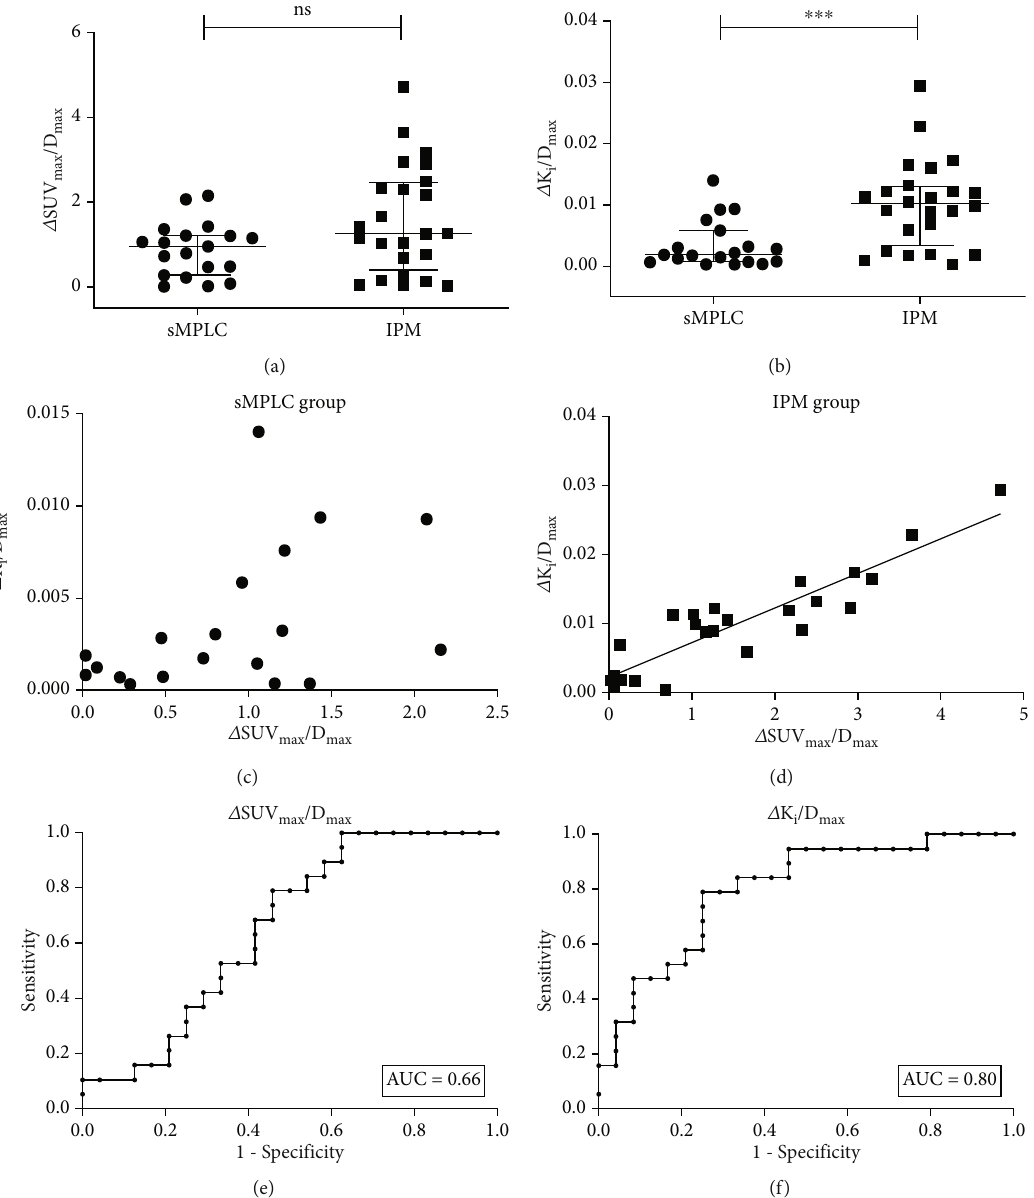
Figure 3: sMPLC vs. IPM: absolute di ff erences of SUV / D or K i / D and ROC curve analysis. (a, b) △ K i / D was more sensitive max max max max / D in identifying sMPLC. Data are shown as median with interquartile range. Mann – Whitney test, ∗∗∗ p < 0 : 001 , than △ SUV max max / D and △ K i / D in the sMPLC and IPM groups. (c) There was no ns=not signi fi cant. (c, d) Correlation between △ SUV max max max / D and △ K i / D in the sMPLC group. (d) There was a good correlation correlation (Pearson r = 0 : 45 , p > 0 : 05 ) between △ SUV max max max / D and △ K i / D in the IPM group. (e) ROC curve ( AUC = 0 : 66 , (Pearson r = 0 : 91 , 95% CI: 0.79-0.96, p < 0 : 0001 ) between △ SUV max max max / D . (f) ROC curve ( AUC = 0 : 80 , moderate diagnostic value) for △ K i / D . For the optimal cut-o ff value low diagnostic value) for △ SUV max max max = 0 : 0059 with a sensitivity of 79% and speci fi city of 75%, the corresponding false-positive and false-negative rate was 25% and of △ K i / D max